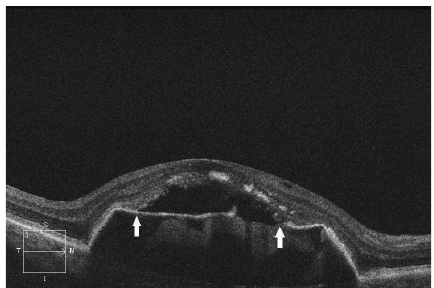
Figure 1: SD-OCT of a patient from the control group—prean- giogenic dry from of AMD.SD-OCT of the right eye of a patient from the control group with the dry form of AMD 2.5 years after the start of follow-up, showing persistent DPED. DPED symmetrically transitionsintothedetachmentoftheIS/OSphotoreceptorjunction, localized between the two arrows, where the beginning and end of junction detachment are indicated. In addition, the detached IS/OS photoreceptor junction shows uneven reflectivity and thickness of theretinallayer,asignofincipientdegenerativechangesoftheIS/OS junction, which are considered to be the result of the lack of junction nutrition due to its increased distance from the RPE [10,